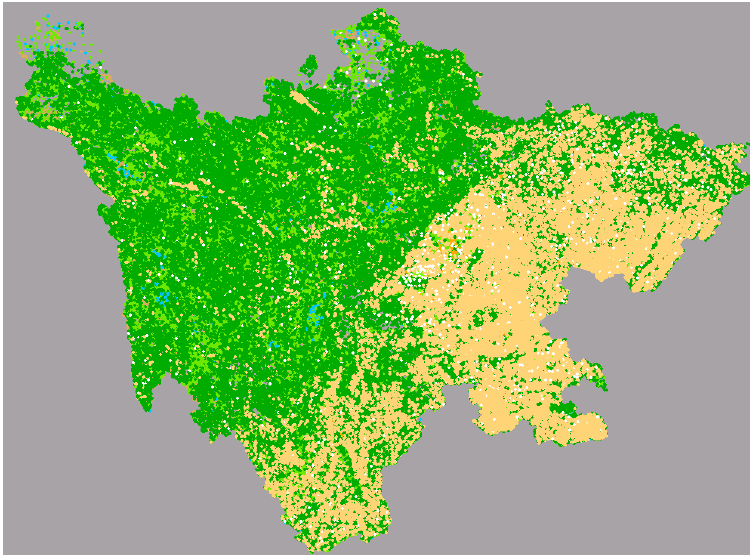
Figure 10. Overview of surface cover data in Sichuan province. The data are full coverage data. The vector data interpreted from the image data include all types of surface features in the province. The geometric complexity of the features exceeds the contour and vegetation features.